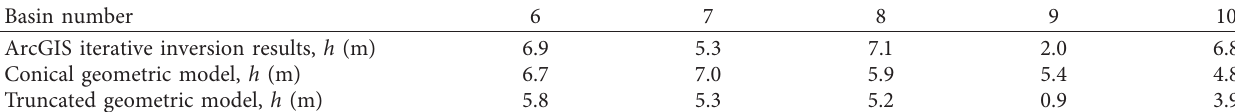
Table 9: Comparison of prediction results.